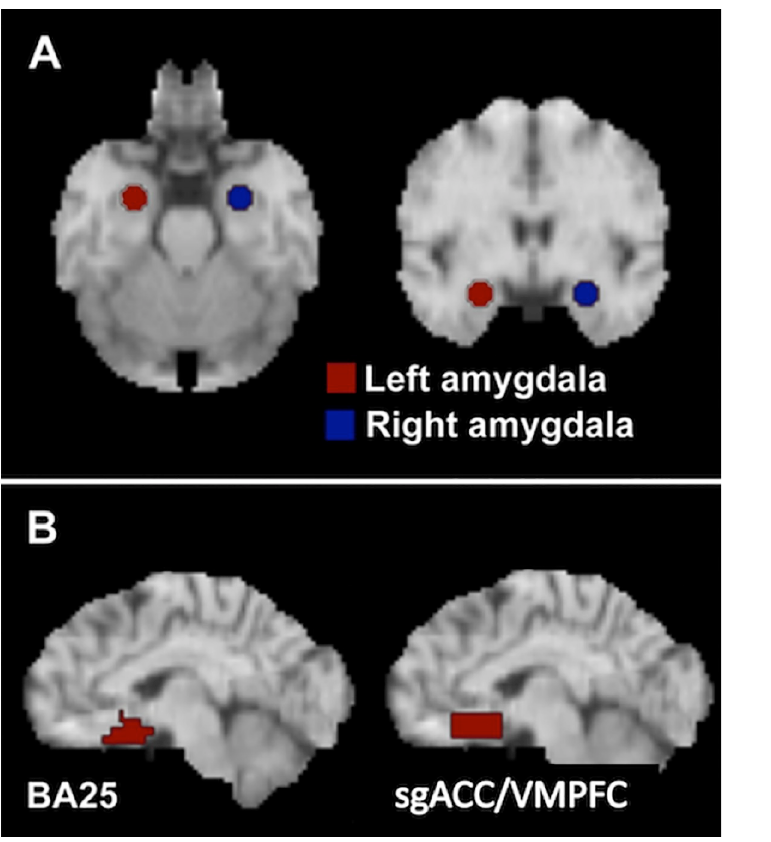
Fig 1. Regions of interest. ( A) Amygdala. (B)